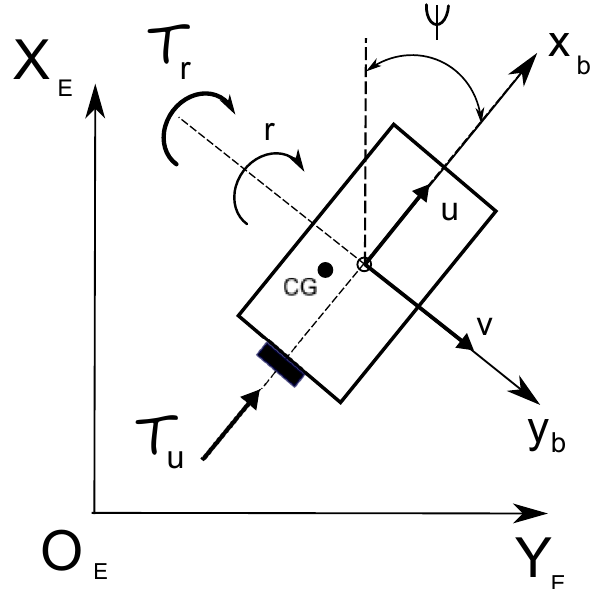
Figure 1. Underwater vehicle model